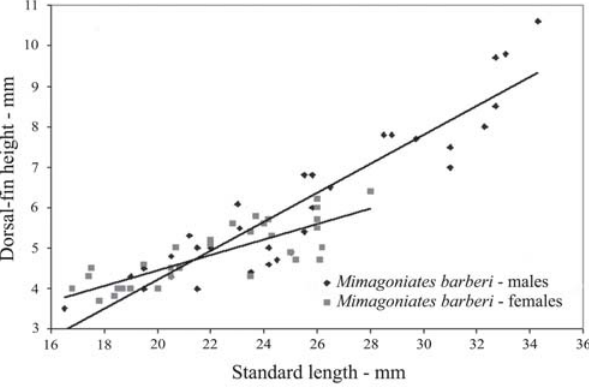
Fig 43. Mimagoniates barberi , dorsal-fin length as function of SL by sex.